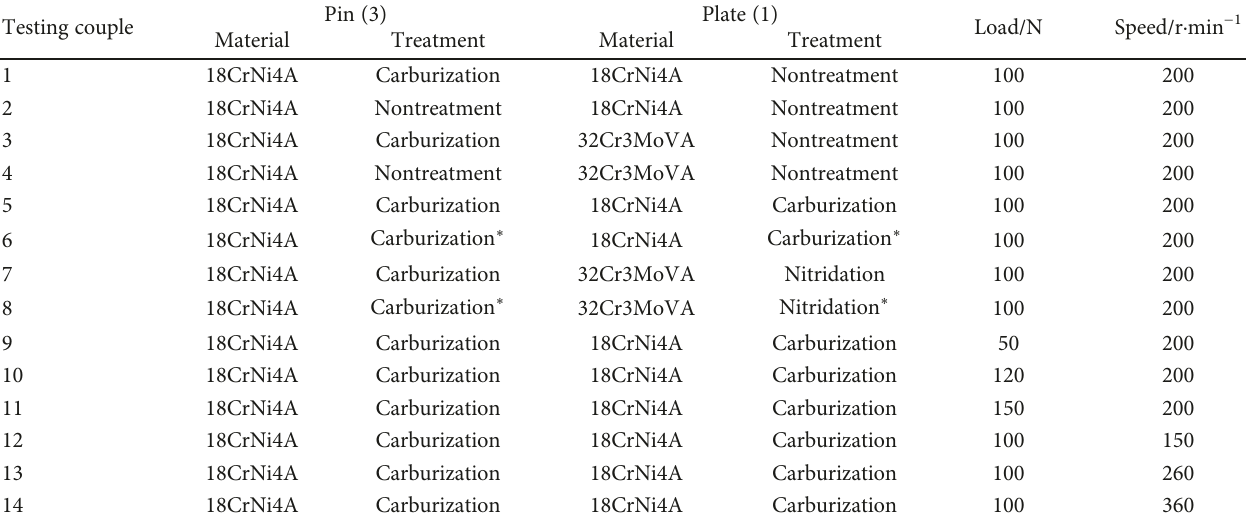
Table 3: Materials and testing conditions.